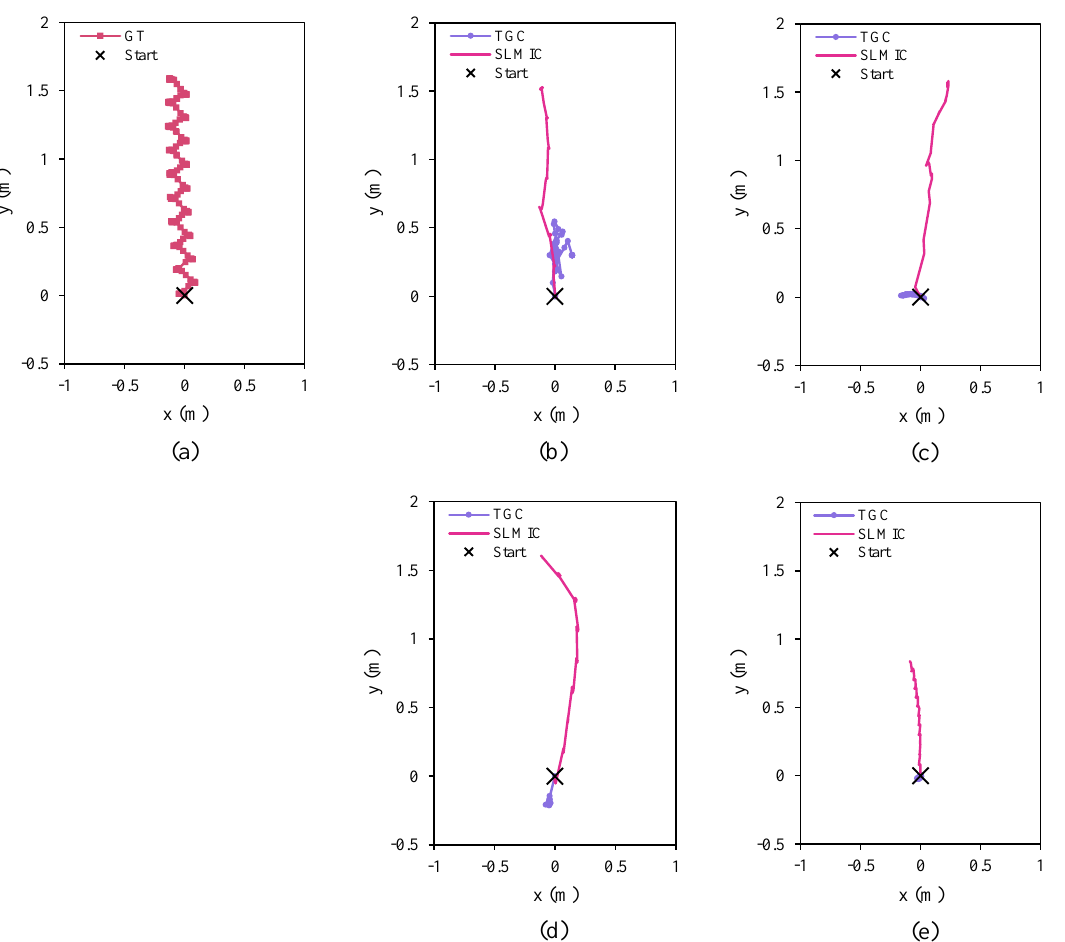
Figure 20. Experimental results of SLMIC compared to previous controller (trotting gait): ( a ) ground truth of healthy robot walking with trotting gait; ( b ) one leg lost (case A); ( c ) two adjacent legs lost (case B); ( d ) two diagonal legs lost (case C); ( e ) two adjacent legs and one limb